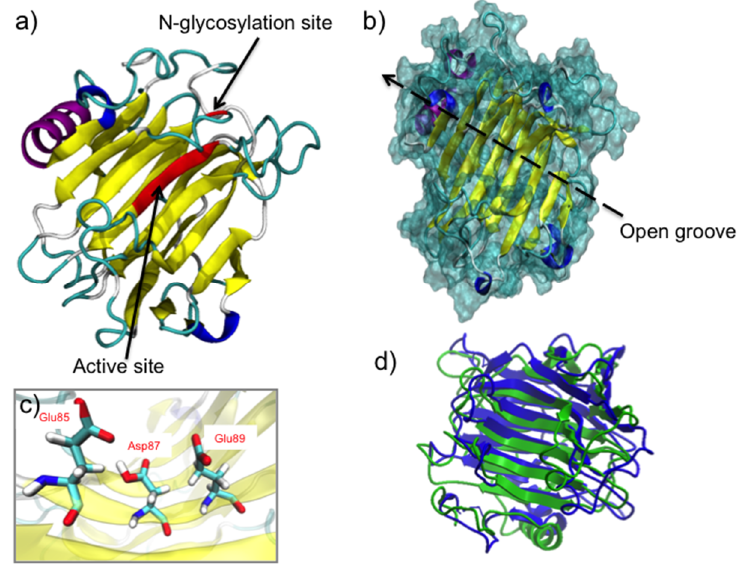
Figure 2. FcXTH2 protein model. ( a ) The three-dimensional (3D) model of FcXTH2 was built by comparative modeling using TmNXG1 (Protein Data Bank (PDB) code: 2UWA) as template. The active site ( β -sheet 7) and the N-glycosylation site are highlighted in red. ( b ) FcXTH2 in surface representation; the location of the groove is indicated as a black line. ( c ) Zoom of the active site showing the relevant residues (in licorice view). ( d ) Structural superposition of the FcXTH2 model and the 2UWA structure. The cartoon structure of the template is colored in blue and that of FcXTH2 in green. The root mean square deviation (RMSD) value of 8.6 Å.